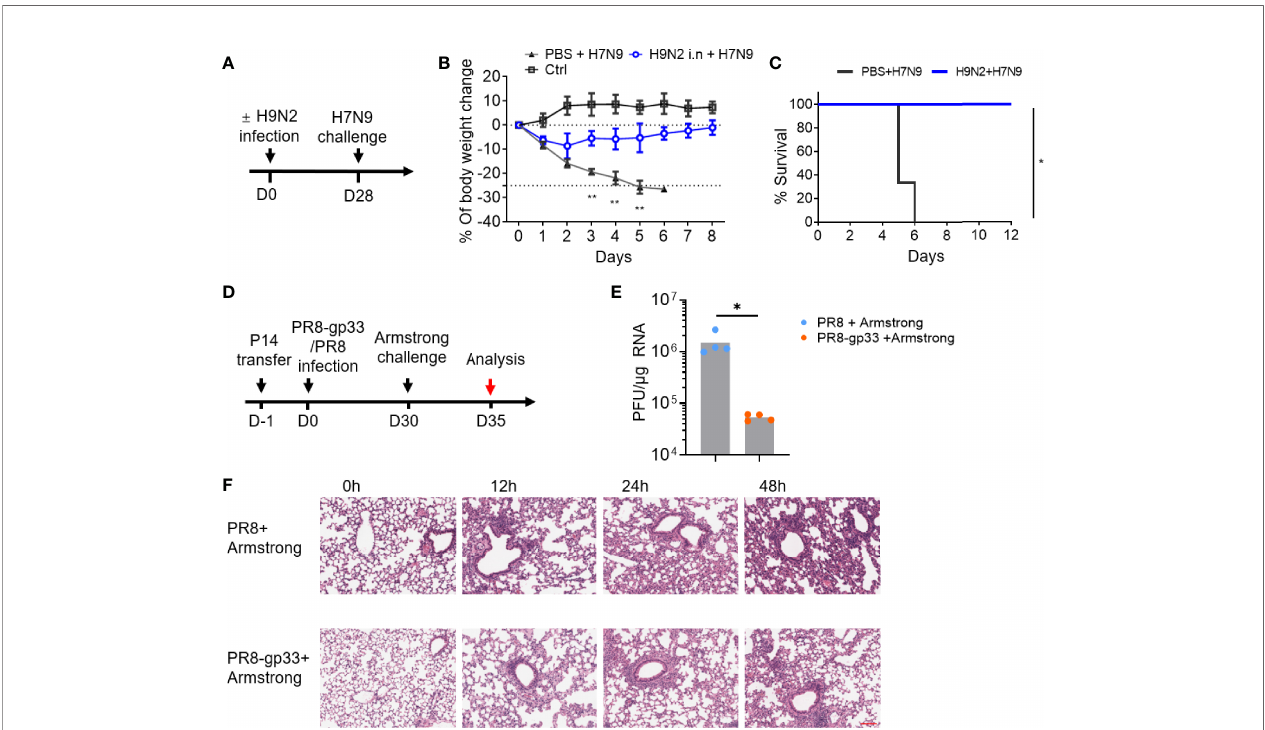
FIGURE 1 | Mouse infection models demonstrated the cross-protectivity of T-cell memory response to virus infection. (A – C) Exploration of harmless H9N2 virus as a live vaccine against pathogenic H7N9 virus. The sequential intranasal infections of naïve mice with H9N2 and H7N9 viruses were performed according to a 4-week schedule (A) . Following H7N9 challenge, the mice were daily monitored for weight changes with the control (ctrl) group representing the animal group only receiving PBS (B) and survival (C) . (D – F) An experimental approach combining adoptive transfer and sequential virus infections to demonstrate cross protectivity of memory CD8+ T cell via cross-recognizing a single epitope. The experimental scheme was illustrated in (D) . In brief, mice were adoptively transferred with 5 ×10 4 naïve P14 CD8+ T cells, then i.n. infected with sublethal dose of PR8 or PR8-gp33 as the prime, and 30 days later challenged with LCMV Armstrong at 2 × 10 5 of plaque ‐ forming units (PFU). Shown in (E) was lung viral load determination at day 5 post LCMV Armstrong challenge, and in (F) were representative images of H&E-stained lung sections sampled at the indicated time points post challenge. Scale bar (red): 100 m m. Data are representative of two or three independent experiments with n = 3 (B, C) . Mean ± SEM (B) . * p < 0.05, ** p < 0.01; Log-rank test (C) ; Mann – Whitney U test (E)